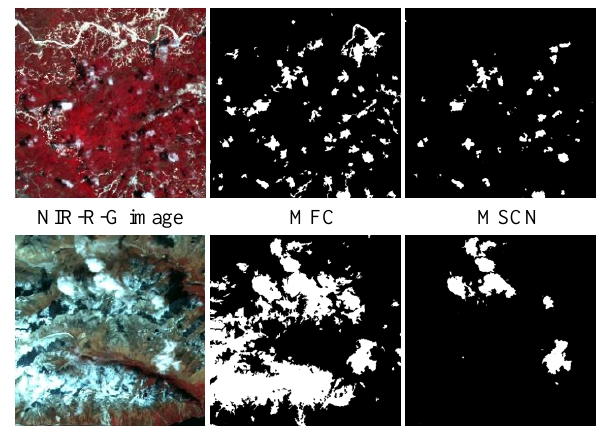
Figure 3. Accuracy tests of the proposed MSCN method.